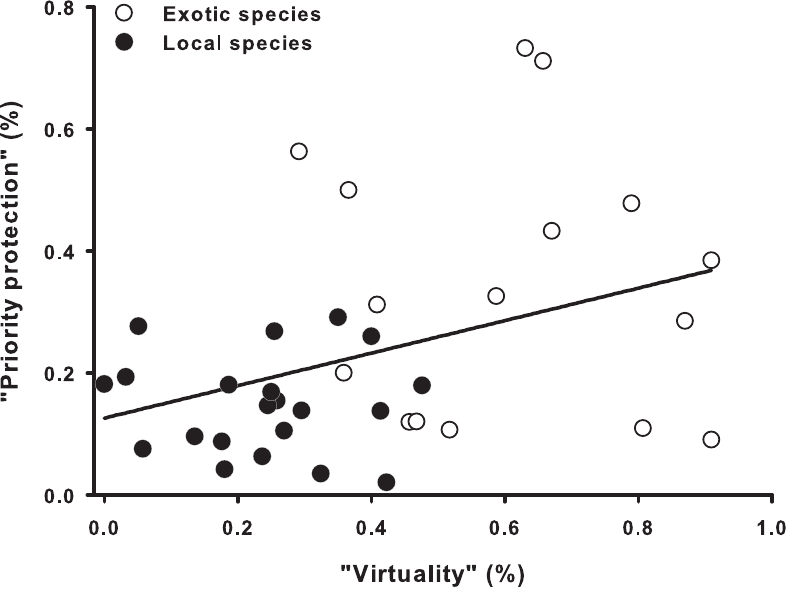
Figure 3. Relationship between ‘‘virtuality’’ and ‘‘priority protection’’. ‘‘Virtuality’’ is given as a proportion, from 0 for species for which live specimens have already been seen/observed by all of the interviewed schoolchildren, to 1 for species that have never been seen/observed. ‘‘Priority protection’’ is given as a proportion, from 0 for the species that are not declared as ‘‘priority protected’’ by schoolchildren to 1 for the species rated as priority protection by all the interviewed schoolchildren. Exotic and local species are represented by open and filled circles respectively. The equation for the regression line is y=0.126 + 0.266x (F 1,36 =5.52, p=0.02).